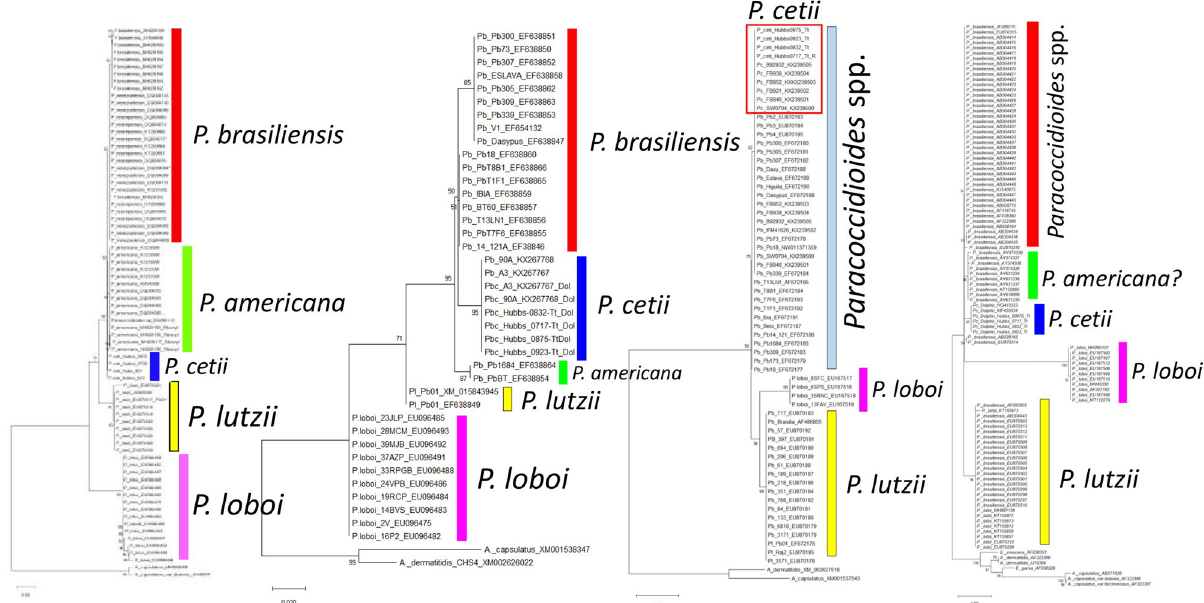
Figure 5. Evolutionary analyses inferred by Maximum Likelihood of the ADP-rf , CHS4 , KEX , and ITS, DNA sequences respectively, using homologous DNA sequences from well-known dimorphic Onygenales as outgroup (Table S1). In these trees, P. lutzii (yellow bars) consistently grouped as monophyletic clusters sister to P. loboi (pink bars). Except for Kex DNA sequences, grouping P. cetii (red rectangle) with P. brasiliensis (sensu lato) (bluish bar), the other DNA sequences in these analyses ( ADP-rf, CHS4 , and ITS) grouped P. cetii (blue bars) in monophyletic clusters. Paracoccidioides americana (green bars) clustered as a monophyletic group using ADP-rf and CHS4 DNA sequences and the other Paracoccidioides species (red bars) grouped in a single cluster. Using ITS DNA sequences, a poorly supported cluster was tentatively labelled as P. americana (green in both statistical approaches (Figs. 4bc) (see above). In addition, the phylogenetic evolutionary history using ADP-rf , CHS4 , KEX partial coding homologous DNA sequences of Paracoccidioides species (including four USA dolphins; the Japanese dolphins do not have homologous DNA sequences in this group), and the complete ITS DNA sequences (including six dolphins from Brazil = 1, Cuba = 1, USA = 4) were investigated (Table S1). Phylo- genetic analysis using the above partial coding and ITS homologous DNA sequences from dimorphic Onygen- ales as outgroup showed comparable threes (Fig. 5). ADP ribosylation factor and CHS4 partial DNA sequences showed similar clusters to that reported with the Gp43 DNA sequences (Figs. 4, 5). In these trees, P. americana , P. cetii , P. loboi and P. lutzii were placed in monophyletic clusters (Fig. 5). Except for P. loboi and P. lutzii forming two monophyletic clusters, KEX DNA sequences could not discriminate P. cetii from the other Paracoccidioides species (Fig. 5, red rectangle). The evolutionary history of the ITS DNA sequences in this study placed P. cetii (including dolphins in Brazil, Cuba, and the USA), P. loboi , and P. lutzii in three monophyletic clusters, but could not discriminate other Paracoccidioides species (Fig. 5). A poorly supported monophyletic cluster closely related to P. cetii was tentatively labeled as P. americana (Fig. 5, ITS). Geographic distribution, haplotype network, principal component analysis, and population structure of concatenate Gp43 and ADP‑rf DNA sequences. Concatenate data of the Gp43 plus ADP-rf partial coding DNA sequences (59 DNA sequences) (Table IS) using different statistical programs, con- sistently grouped Paracoccidioides species in this study into five clusters (Fig. 6). Based on recognized areas were cases of human and dolphin disease occur, the geographical distribution of these species is shown in Fig. 6a. The haplotype of P. cetii from dolphins is found around the coastal areas of the Americas (blue + green haplotype) (Japanese cases are not shown), whereas the haplotypes of the other Paracoccidioides species ( P. americana = yel- low + pink; P. brasiliensis = red + green + yellow; P. lutzii = yellow + pink) are distributed in several South America countries (Fig. 6a). Paracoccidioides loboi (pink + yellow) haplotype located in the Amazon basin (Fig. 6a) and other Latin American countries (not shown). The haplotype-concatenated data showed five haplotype groups comparable to the results using Gp43 DNA sequences. (Figs. 3, 6b). Correspondingly, PCA (Fig. 6c) and STRU CTU RE (Fig. 6d–f) analyses consistently grouped Paracoccidioides species into five populations. The LnP(D) as well as Evanno’s ΔK of the Gp43 plus ADP-rf concatenate partial coding DNA sequences was K = 5 used to build the data (Fig. 6d). The triangle plot in Fig. 6f is an analogous result obtained from STRU CTU RE software out- puts (Q4 = P. lutzii , Q5 = P. loboi other species, top of the tringle). Similarly, phylogenetic analysis of the concat- enate data, inferred by using Maximum Likelihood method and Kimura 2-parameters model, showed analogous results to the analysis using Gp43 DNA sequences (Figs. 4b, 1c). Japanese dolphins lack ADP-rf DNA sequences at the NCBI thus, they were not included in this analysis. Phylogenetic analysis of the concatenated data supports the placement P. americana , P. cetii , P. loboi and P. lutzii in four monophyletic clusters (Fig. 1c).